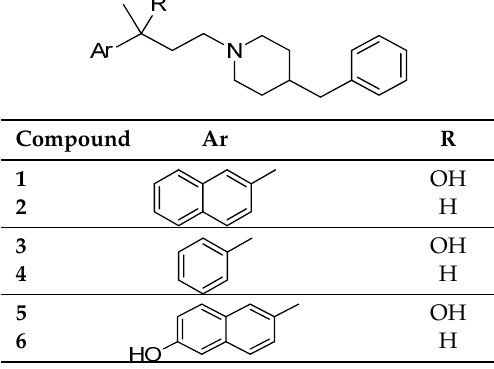
Table 1. Molecules under investigation.